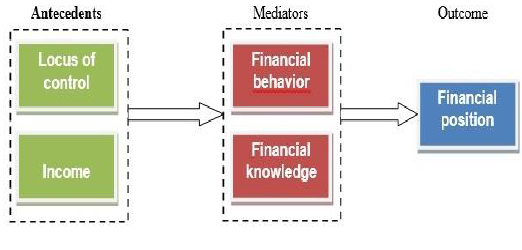
Figure 2. The Conceptual Model